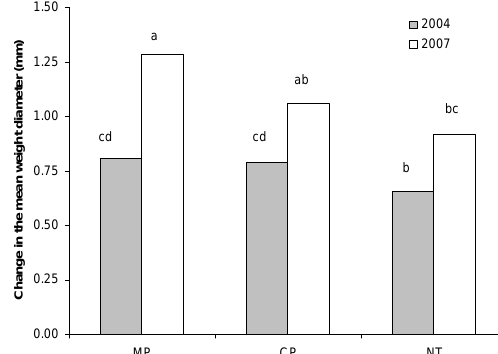
Figure 2. Effect of time on change in the mean weight diame- ter (CMWD,mm). Different letters indicate significant differences ( p